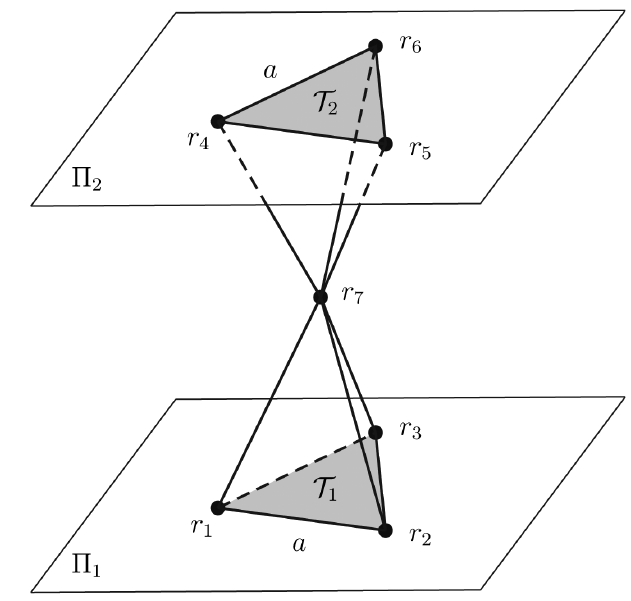
Figure 1 - Illustration of the configurations studied here. The position vectors r , r and r are at the vertices of an equilateral triangle 1 2 3 T 1 whose sides have length a > 0, r , r and r are at the vertices of an 4 5 6 equilateral triangle whose sides have length a > 0 and r is out of the 7 T 2 parallel distinct planes Π and Π that contain and , 1 2 T 1 T 2